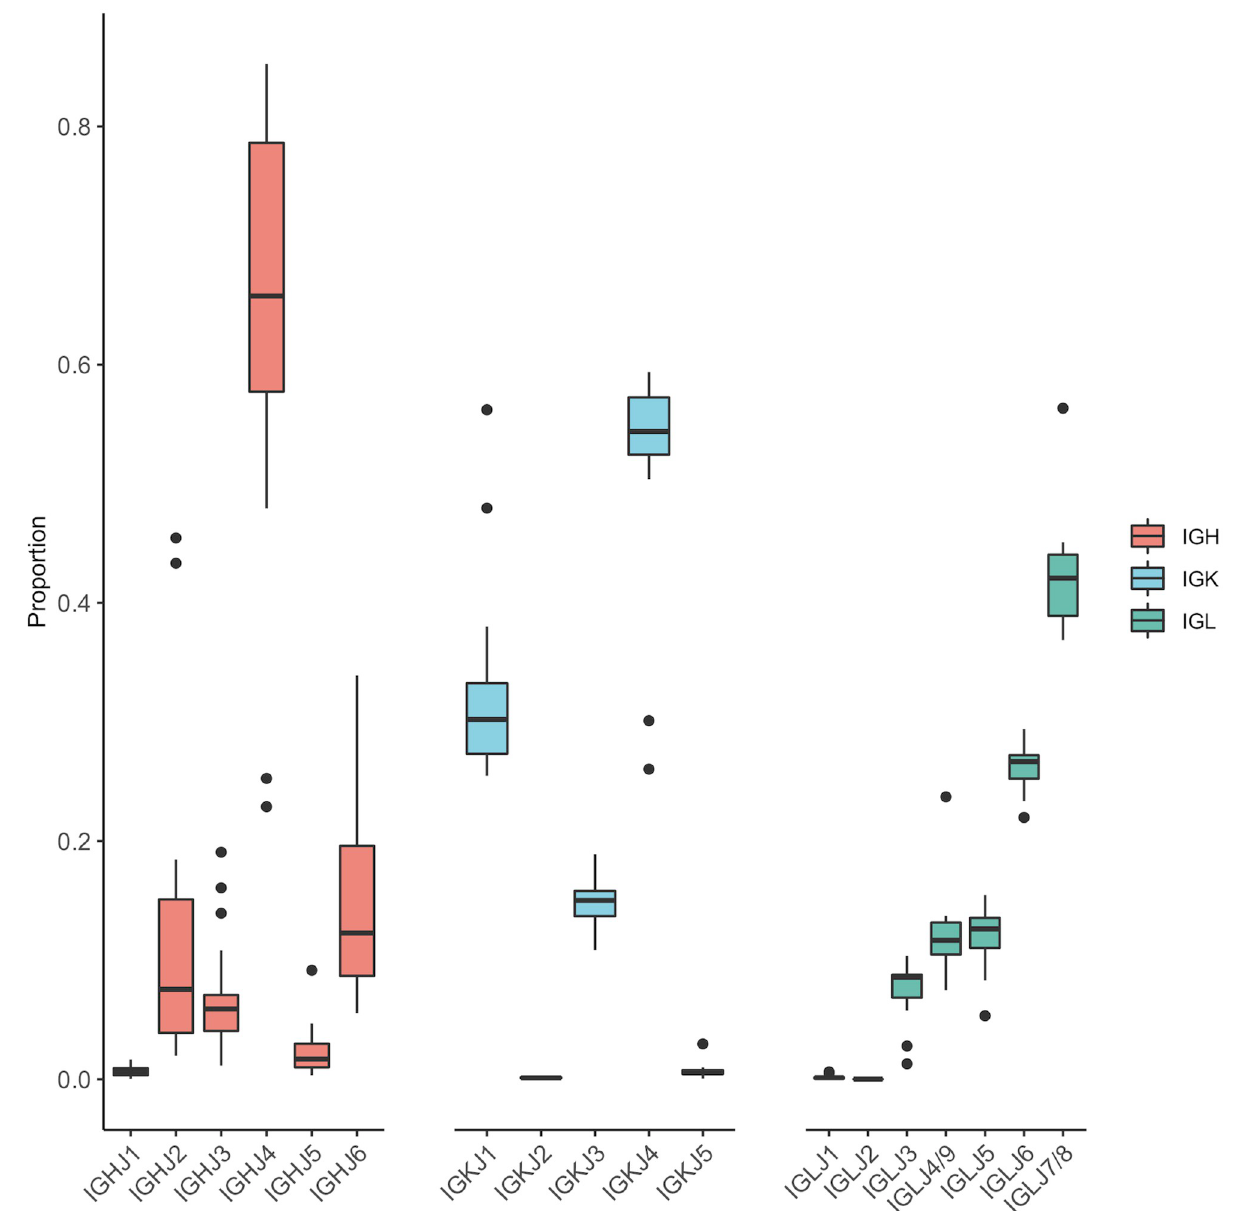
Fig 7. J gene usage by chain. Genes are in locus order from left to right for IGH, IGK, and